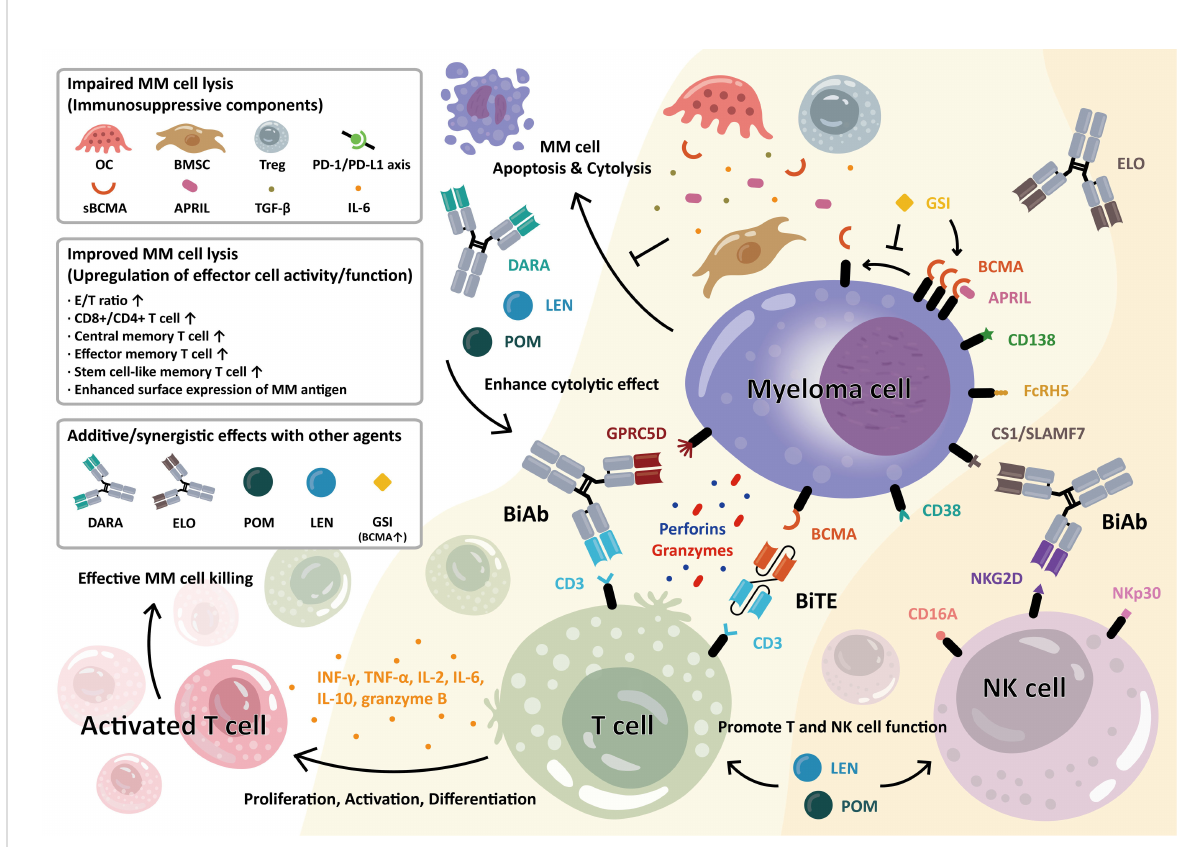
FIGURE 1 Anti-myeloma activity of bispeci fi c antibody (BiAb) and bispeci fi c T-cell engager (BiTE) molecules in the bone marrow MM microenvironment. T-cell – redirecting BiAb and BiTE simultaneously bind to the myeloma-speci fi c antigens on MM cells and CD3 on T cells. MM antigens include BCMA, CD38, CS1/SLAMF7, GPRC5D, and FcRH5, as indicated. Upon engagement, the immune synapse is formed, followed by the production and secretion of cytolytic molecules, i.e., perforin and granzymes, from T cells, resulting in MM cell lysis. This further induces T-cell activation, proliferation, and differentiation into various memory subsets. The BiAb/BiTE-mediated T-cell activation leads to increased levels of granzyme B, IFN- g , IL2, IL6, IL8, IL10, and TNF- a . The BiAb/BiTE-mediated MM cell killing is negatively affected by cellular and molecular factors including bone marrow stromal cells (BMSC), osteoclast (OC), regulatory T cells (Treg), a proliferation-inducing ligand (APRIL), transforming growth factor- b (TGF- b ), interleukin-6 (IL-6), soluble BCMA (sBCMA), and upregulation in PD-L1/PD1 axis. Conversely, upregulation in effector/target (E/T) ratio, CD8+ T cell, and differentiated T cells with central and stem-like memory subsets are associated with improved BiAb/BiTE-mediated MM cell lysis. Furthermore, the potency and durability of their ability to kill MM cells could be enhanced when combined with current standard- of-care therapies including daratumumab (DARA), elotuzumab (ELO), lenalidomide (LEN), or pomalidomide (POM). Moreover, soluble BCMA (sBCMA), constantly shed by gamma-secretase (GS), could antagonize optimal MM cell eradication by BCMA-targeting agents. The GS inhibitor (GSI) rapidly blocks the release of sBCMA and augments BCMA protein retention on the MM cell membrane, thereby MM cell targeting and killing are signi fi cantly improved. In a similar manner, the BiAbs or natural killer cell engagers (NKCEs) also target natural killer (NK) cell-related receptor antigens (i.e., CD16A, NKG2D, NKp30) to activate NK cells and augment their anti-MM activities. For example, the anti-CS1 Ab elotuzumab (ELO) enhances NK cell function via CS1 and NKG2D to kill MM cells. (Some elements of Figure 1 are created with